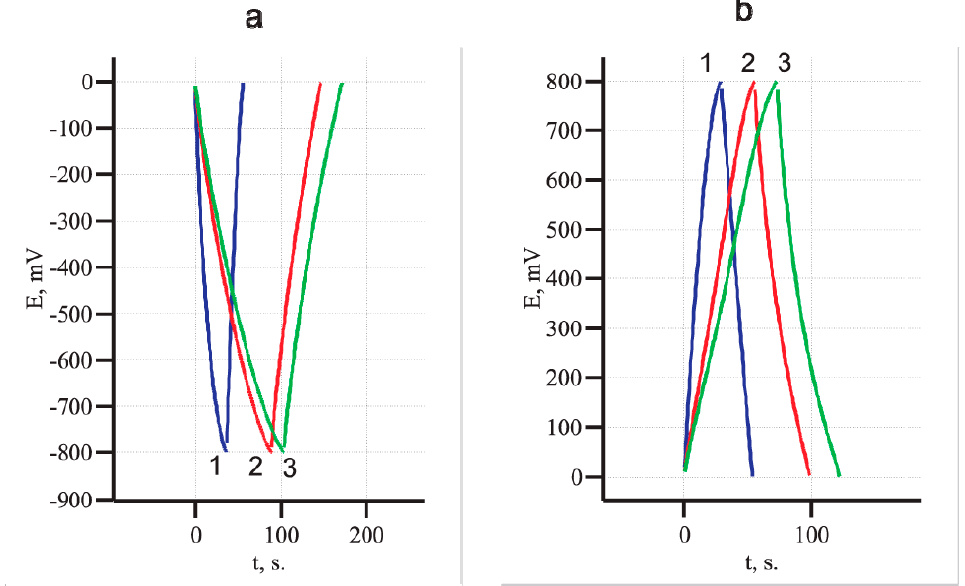
Figure 6. Charge–discharge curves of the MWCNT/Al sample; ( a ) cathodic and ( b ) anodic ranges. Oxidation time, min: 0 (trace 1); 10 (trace 2); 20 (trace 3).